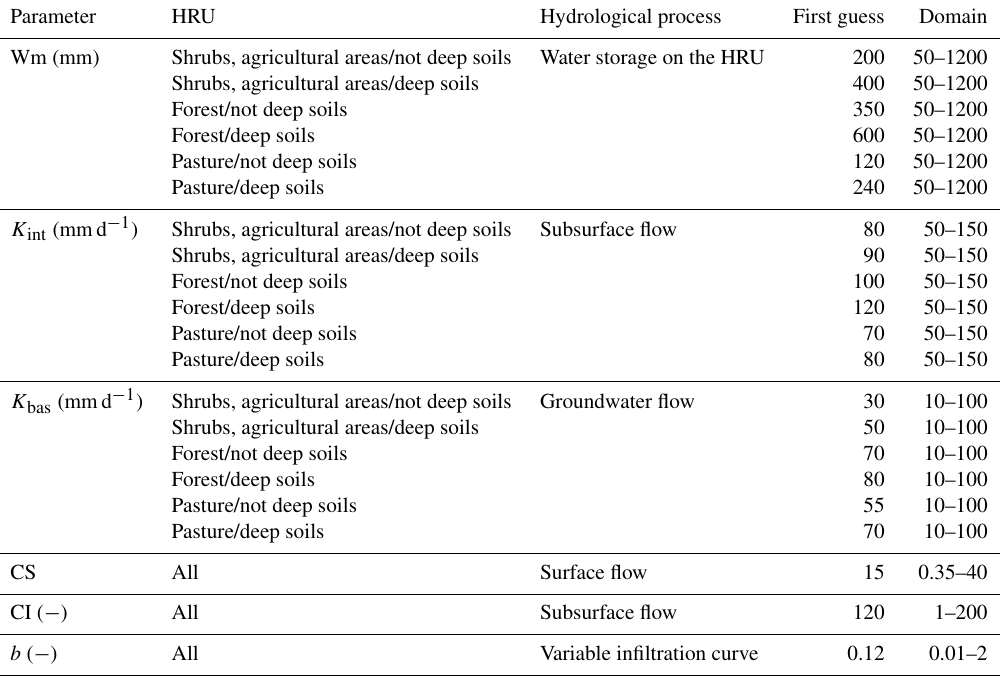
Table 3. Model parameters subjected to the process of automatic calibration for the Peruvian and Ecuadorian Amazon Basin.